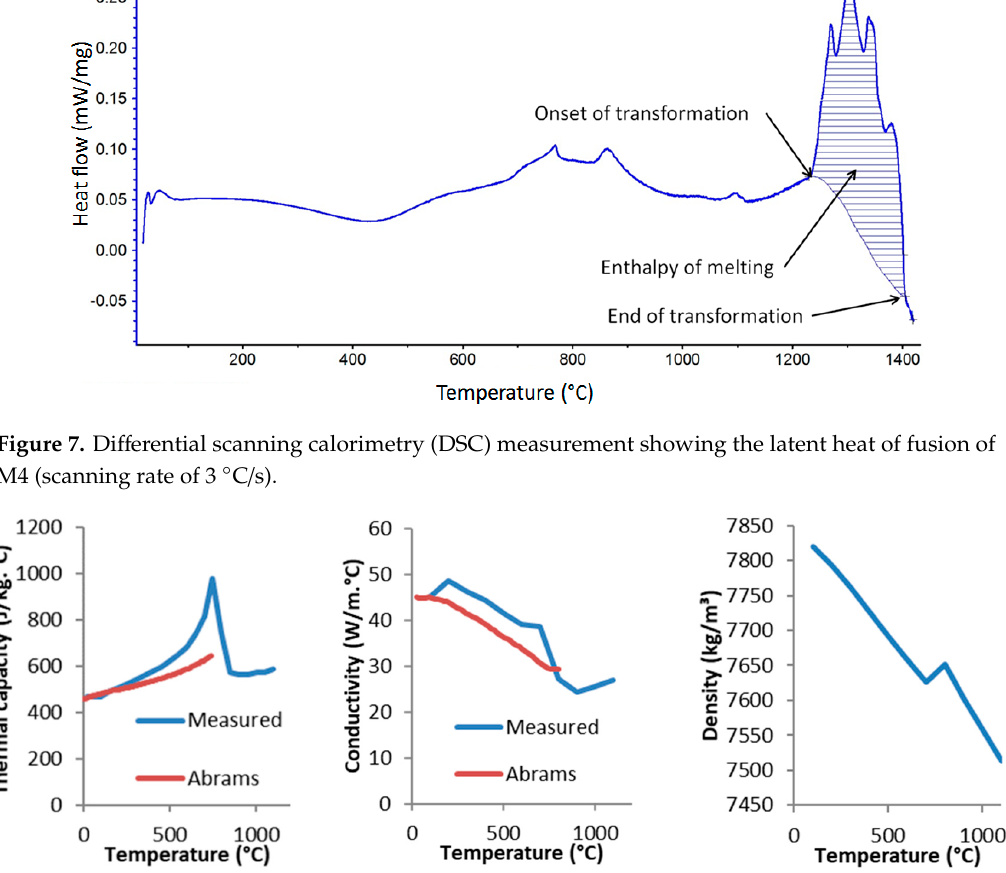
Figure 8. Thermophysical properties of 42CrMo4: ( a ) thermal capacity ( c p), ( b ) thermal